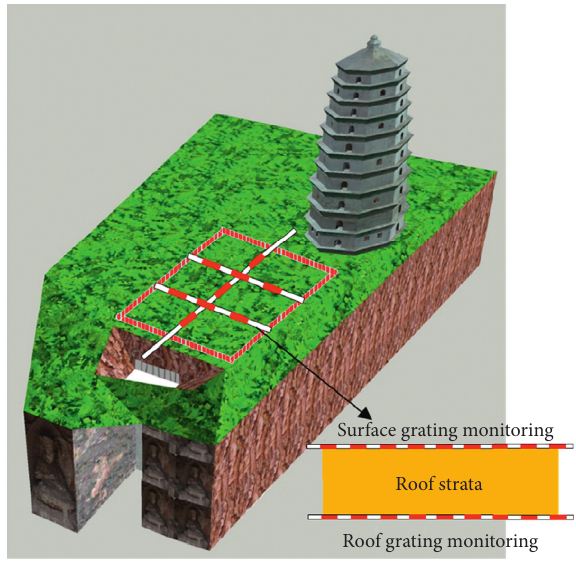
Figure 3: Schematic diagram of the grating